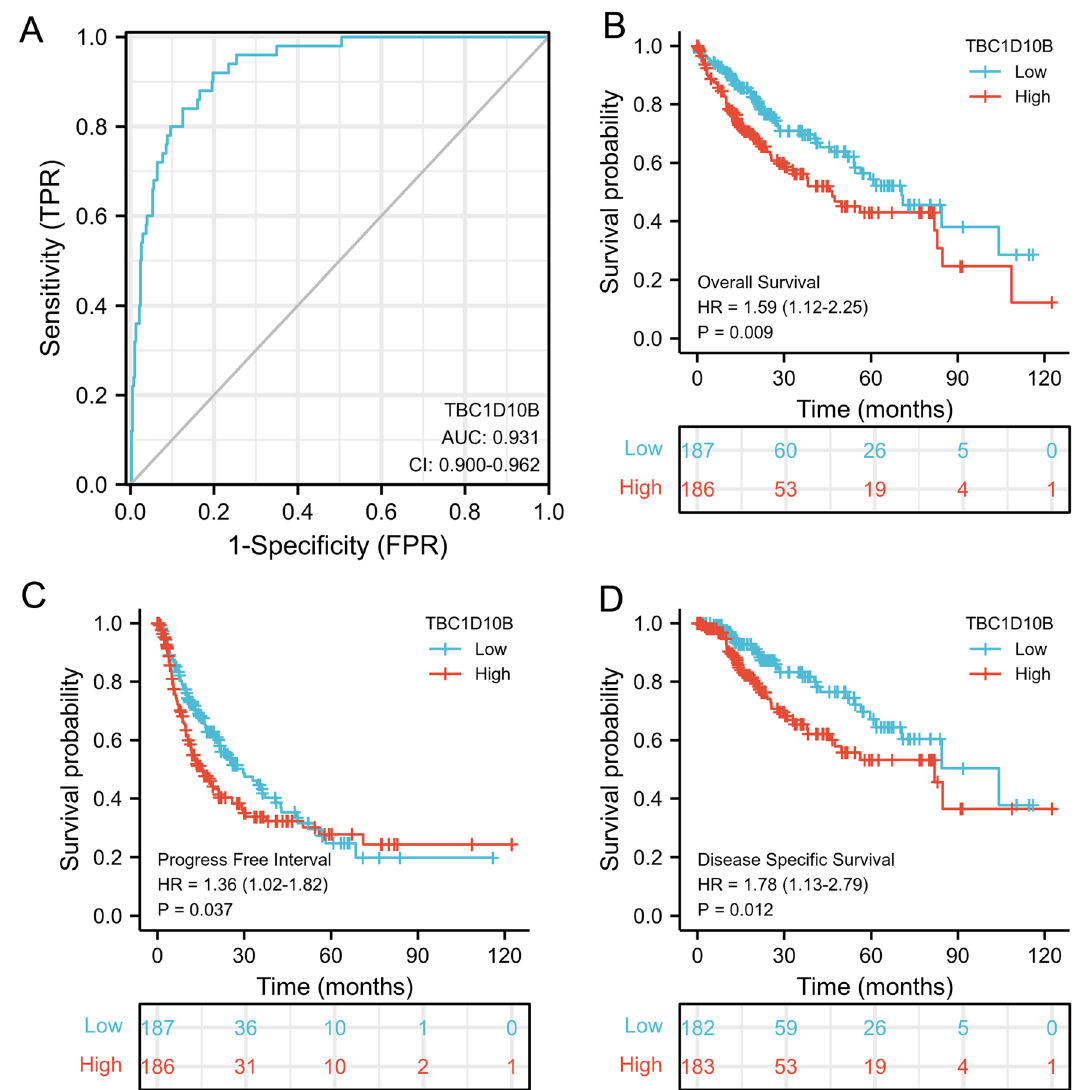
Figure 5. ROC and Kaplan–Meier curves for TBC1D10B gene in LIHC. ( A ) Receiver operating characteristic (ROC) curve for TBC1D10B that differentiates LIHC tissues from healthy controls. (TBC1D10B showed excellent performance as revealed by a ROC curve with an area under the ROC curve (AUC) of 0.93). ( B–D ) Kaplan–Meier analysis of the association between TBC1D10B expression and OS, PFI and